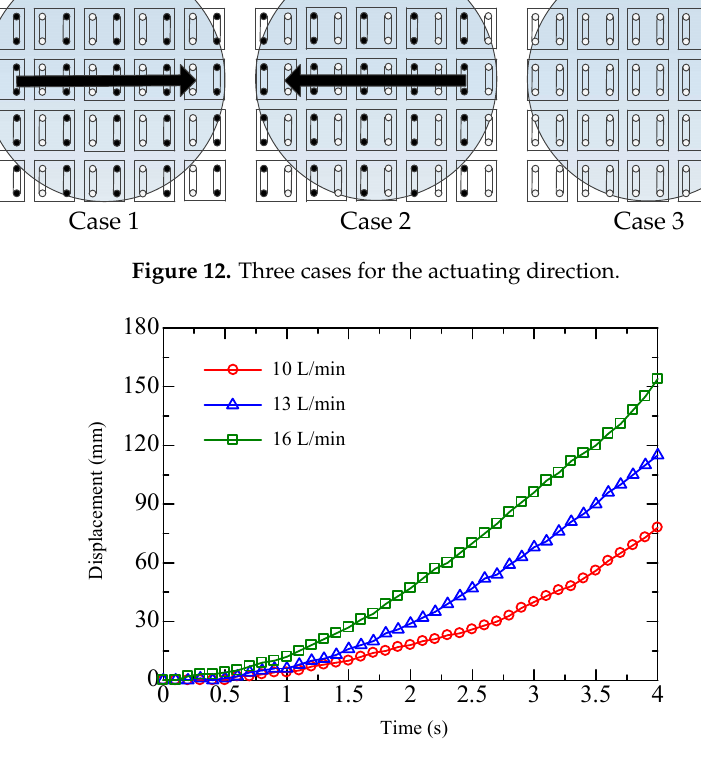
Figure 13. Displacement versus time during open loop control experiment.